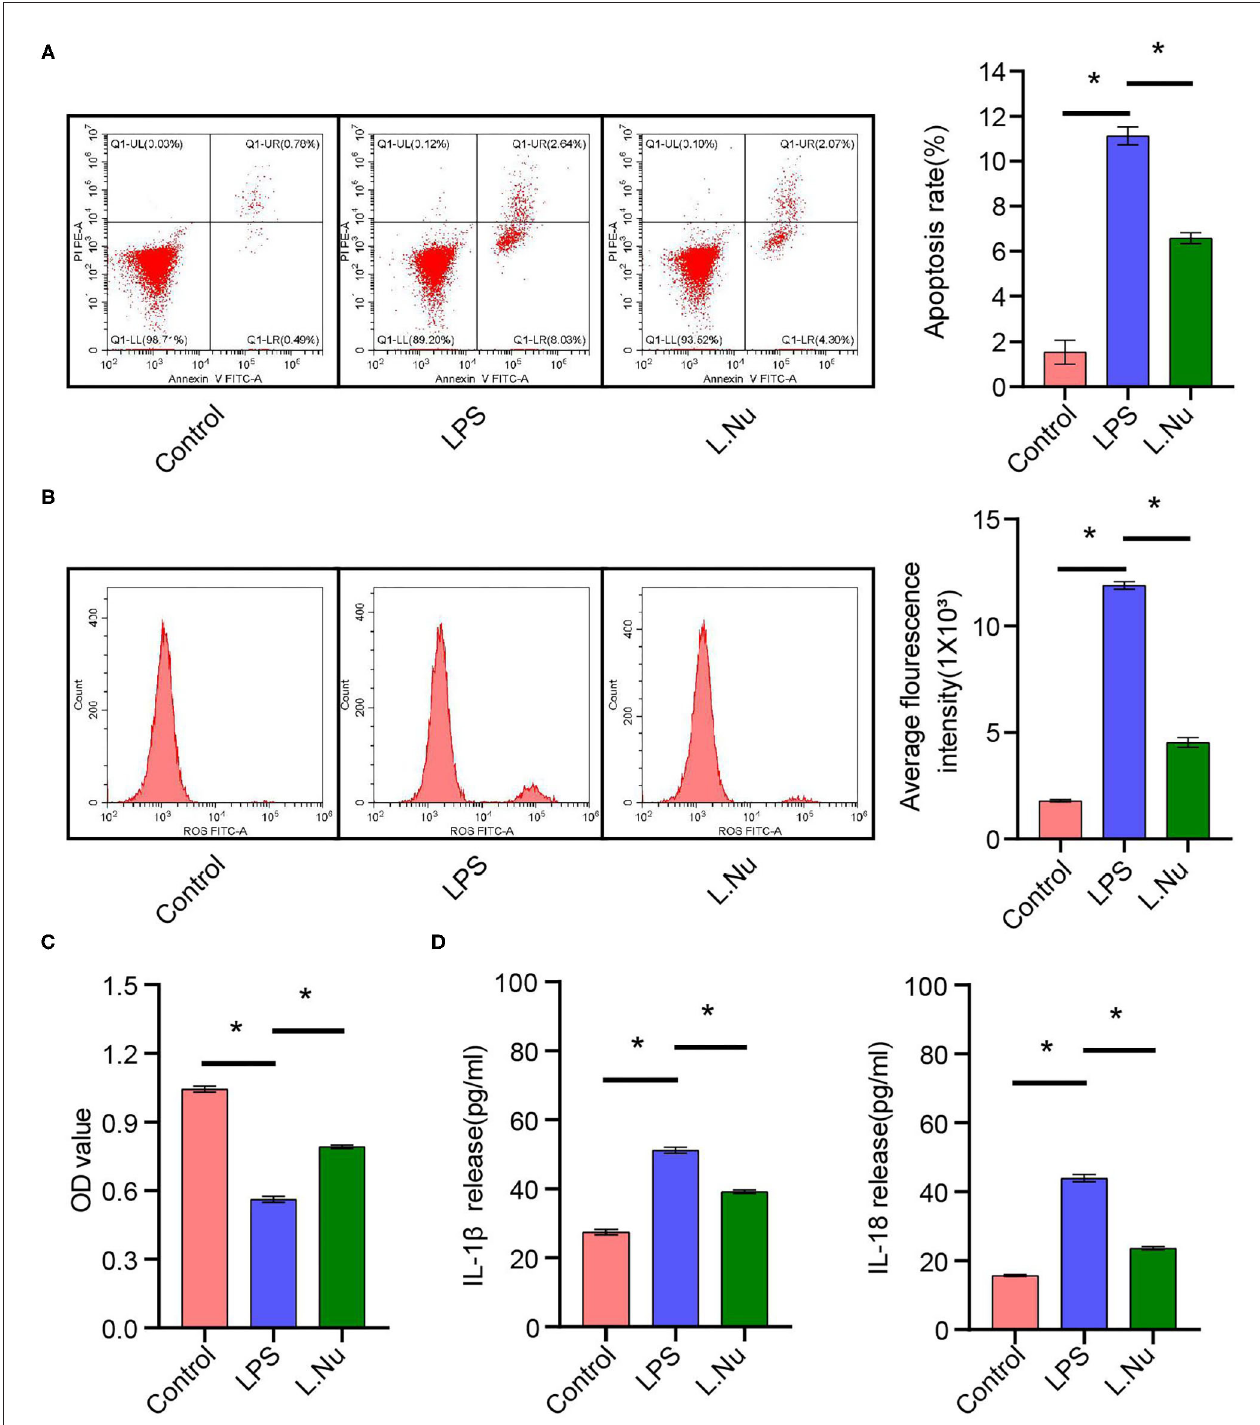
FIGURE 7 | NU9056 inhibited apoptosis and inflammation of microglia in vitro . (A) Apoptosis rate in each group was detected using flow cytometry. (B) The average fluorescence intensity of each group was measured using flow cytometry. (C) Cell viability was tested using CCK8 assay. (D) The IL-1 β and IL-18 release were estimated using ELISA. * P <